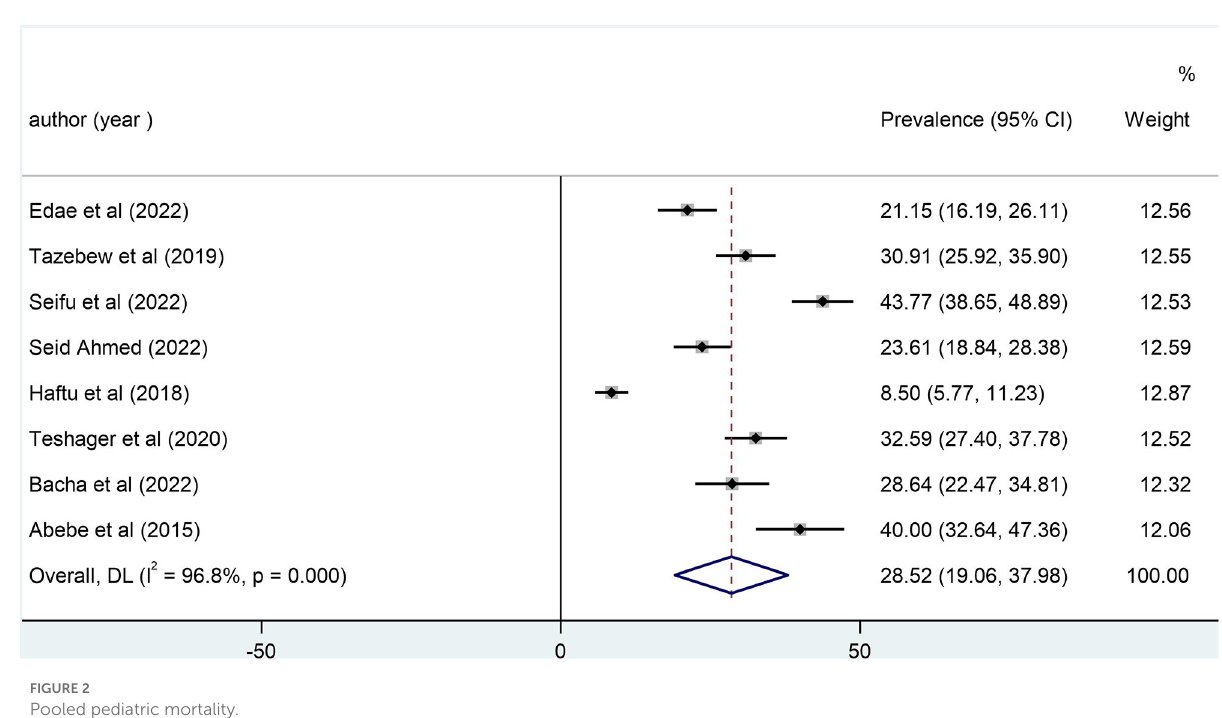
FIGURE2 Pooled pediatric